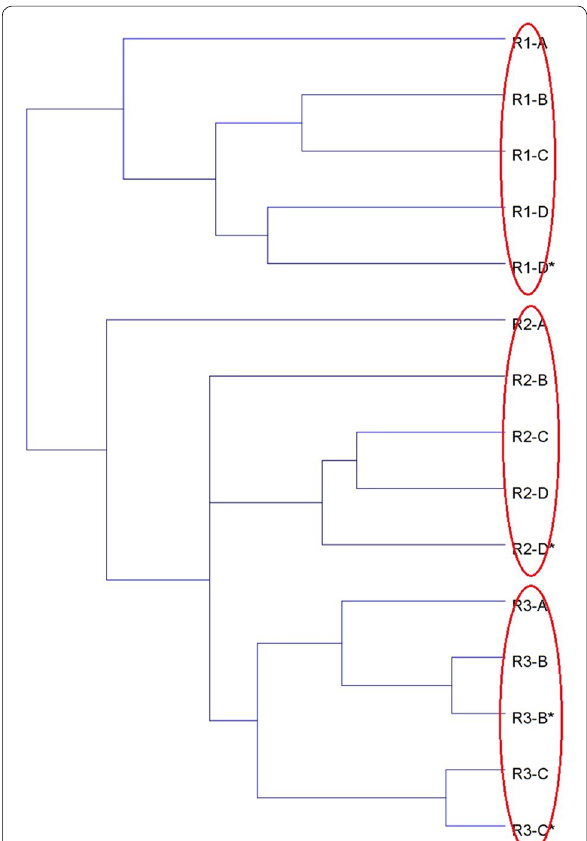
Fig. 1 Cluster analysis of all samples at phylum level based on Bray–